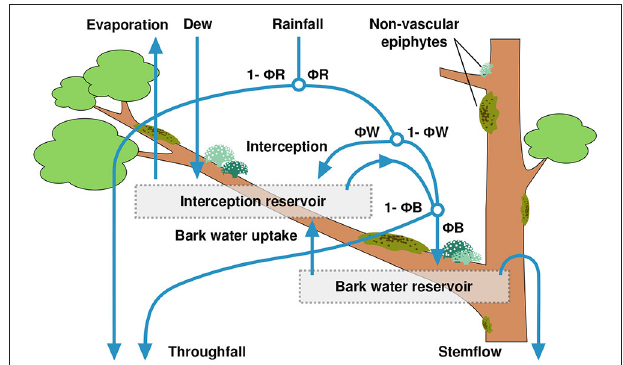
FIGURE 2 | Scheme of precipitation partitioning in the LiBry model, including the newly introduced bark water reservoir. The model parameters 8 R , 8 W , and 8 B control the fractions of rainfall which are directed to throughfall, either directly or via drip from the canopy, into the interception reservoir, the bark water reservoir, or to